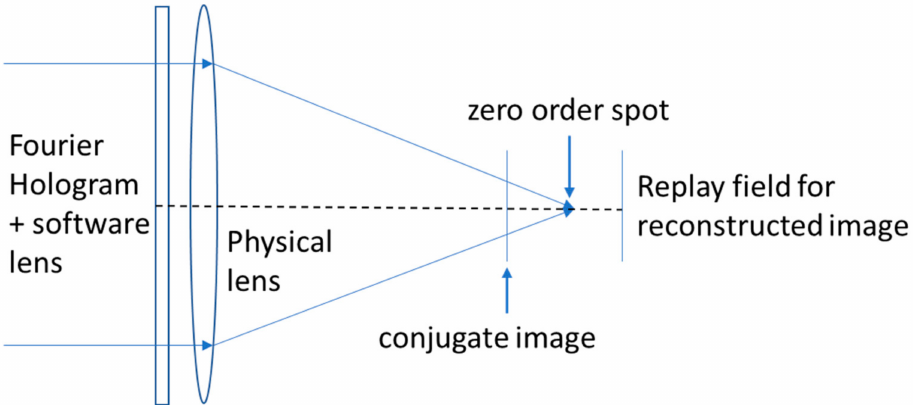
Figure 3. Fourier hologram with a physical lens and software